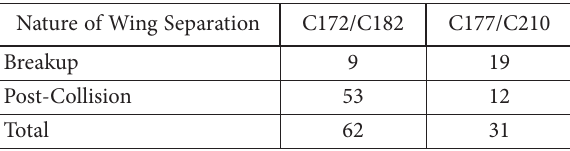
Table 2. Mid-air breakups vs. post-collision wing separations between C172s/C182s and C1772/C210s